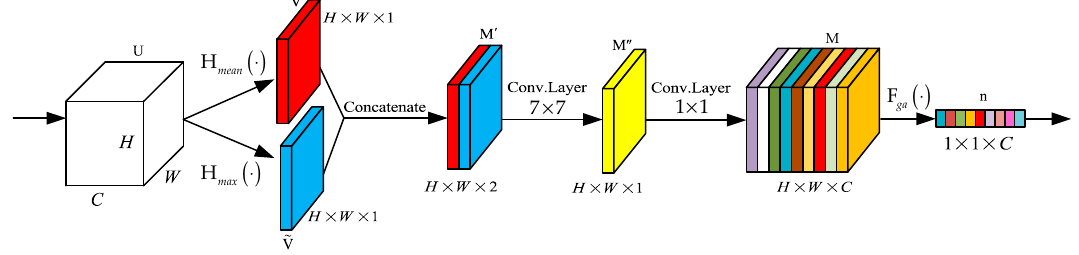
Figure 3. The structure of the average and max spatial (AMS) attention building block.